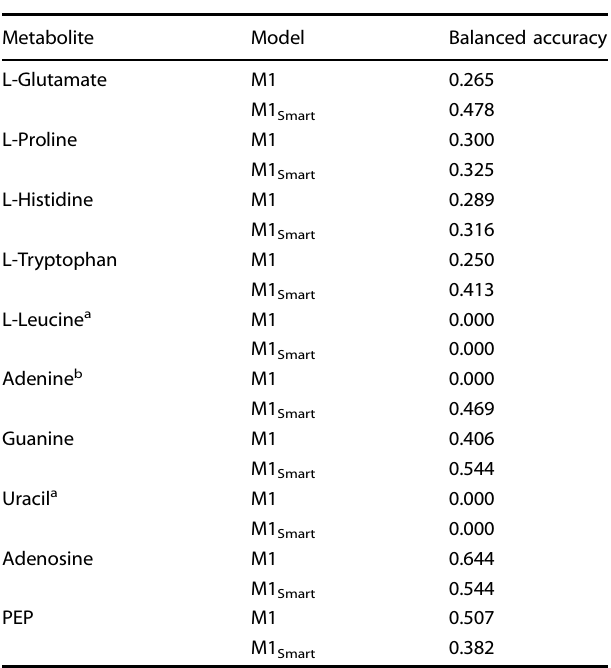
Balanced accuracy of the different models when predicting for signi fi cant changes in metabolite fl ux ( p -value< 0.1, Wilcoxon signed-rank test) in comparison to observed signi fi cant changes in metabolite accumulation ( p -value<0.1, linear model) for all the comparisons available in the